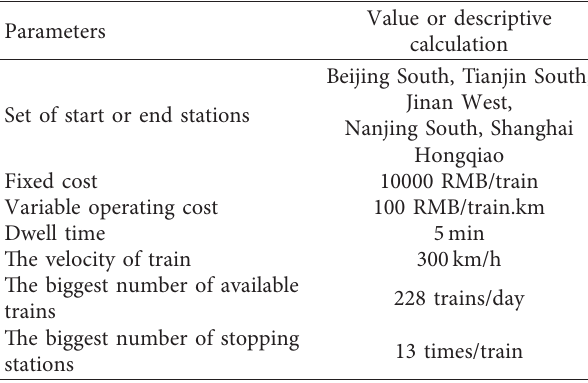
Figure 4: HSR network in China and Beijing-Shanghai HSR line. Table 1: Input parameters of the